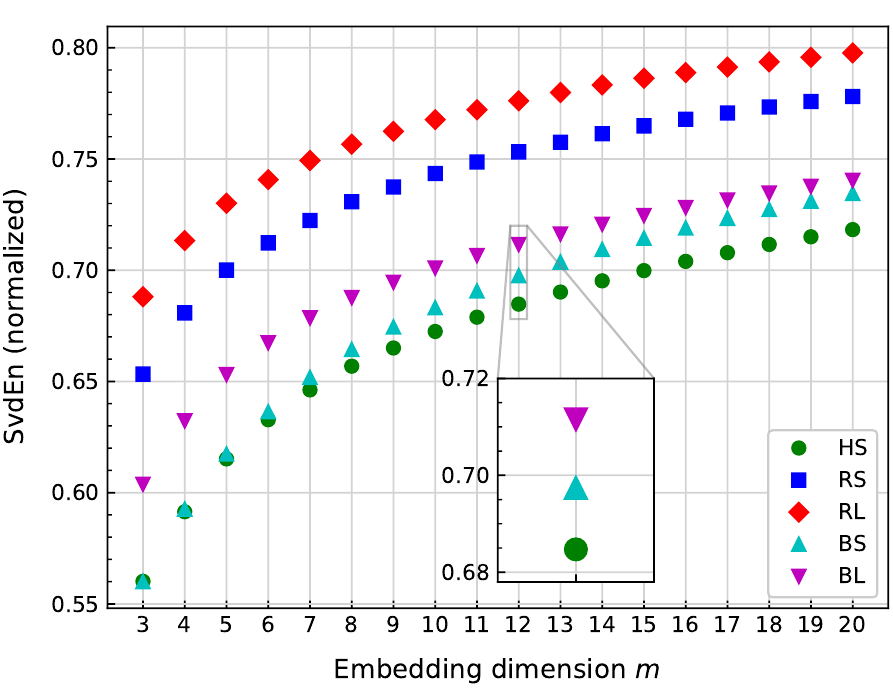
Figure 11. Comparison of the single value decomposition entropy (SvdEn) mean value for several bearing signals at the same rotational speed, with fixed W s = 10,240.